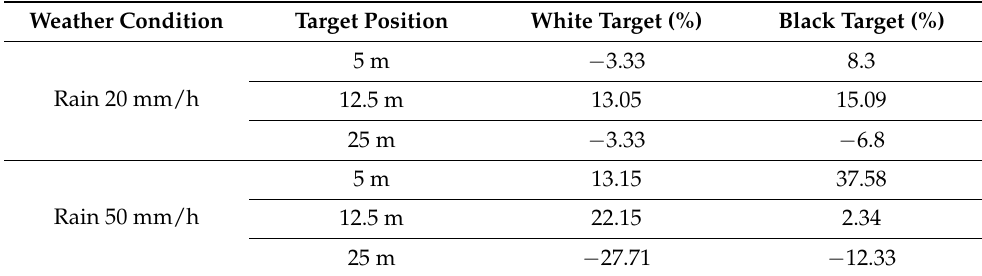
Table 14. 3000 K contrast ratio compared to 6000 K in rain